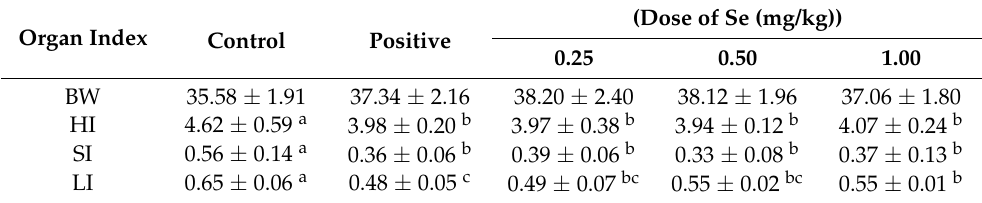
Table 3. The effect of Glycine nano-selenium on organ index after challenge experiment.